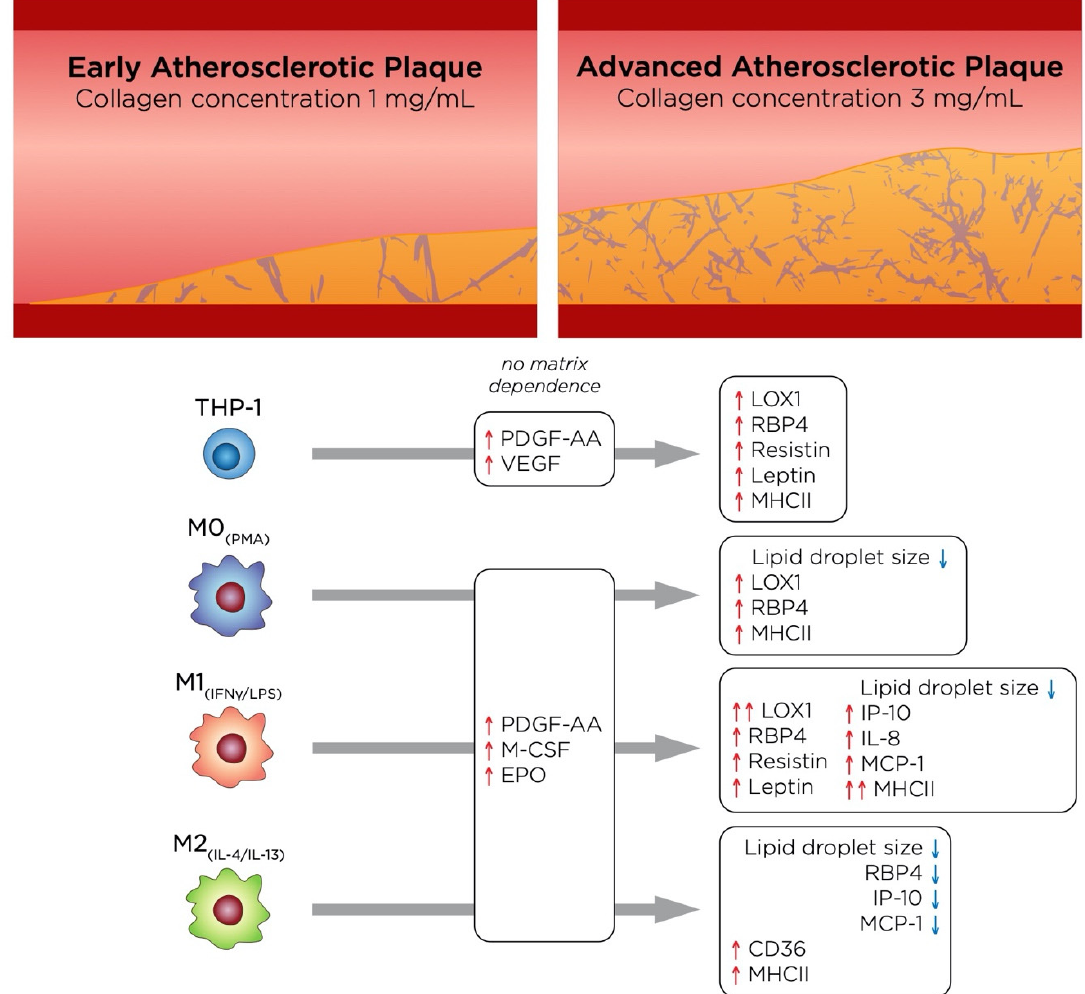
Figure 7. Illustration summarizing the main findings of this study, which highlights the changes undergone by the cells as atherosclerosis progresses.